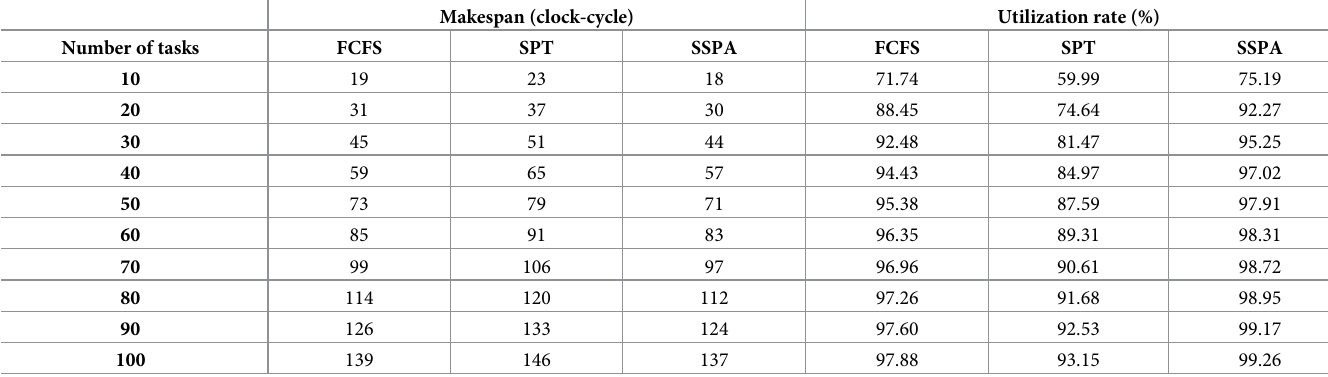
Table 5. Results for variable number of tasks. Makespan (clock-cycle) Utilization rate